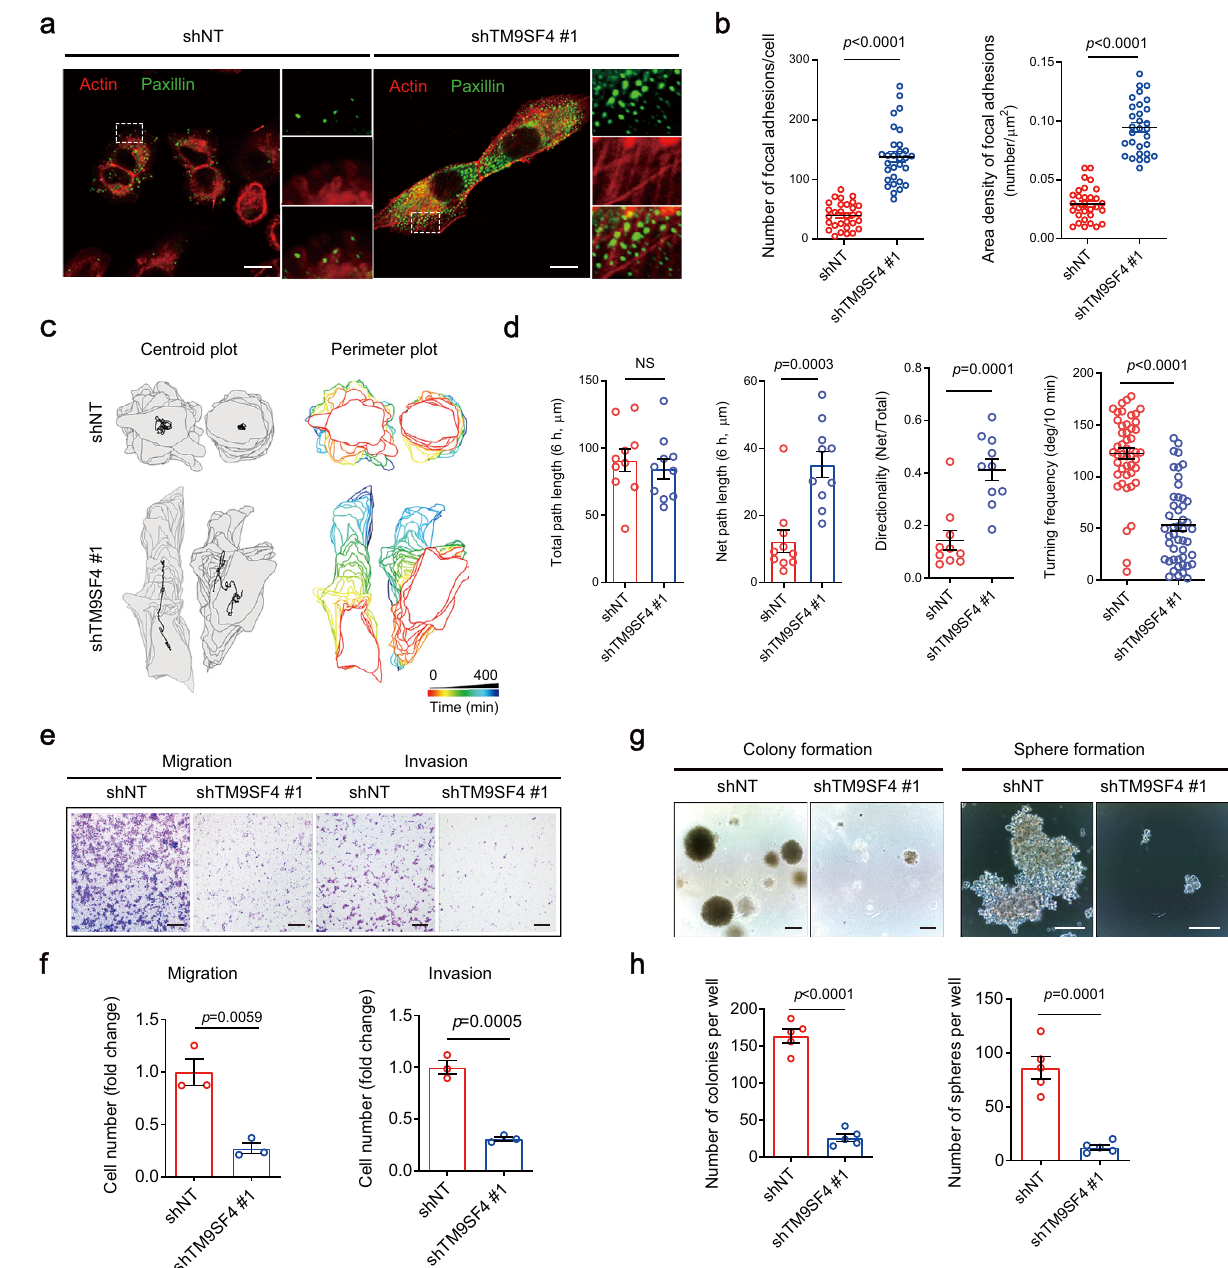
Fig. 5| KnockdownofTM9SF4 alterscancercellmotilitybehaviorandreduces colony/sphere formation of A2780 cells. a , b TM9SF4 knockdown increased the number and density of focal adhesion complexes in A2780 cells, as detected by anti-paxillin antibody. Shown are representative images ( a ) and summary data ( b ) ( n =5 biologically independent experiments, six fi elds of view per experiment). Scale bar=10 μ m. c , d TM9SF4 knockdown altered the motility behavior of A2780 cells. Shown are time lapse tracing of representative control cells and TM9SF4 knockdown cells ( c ) and summary data of cell motility parameters ( d ). Centroid plots showed the moving path of cell center over 400min, depicted as black dot. Perimeter plots showed a stack of cell shapes as they move over time. In d , total pathlengthisthetotaldistancecellsmovedoveraperiodoftime;netpathlengthis the net distance measured from the fi rst cell position to the last cell position (or measured from the initial position of the cell to the fi nal position of the cell); directionality is the ratio of the net path length to the total path length; turning